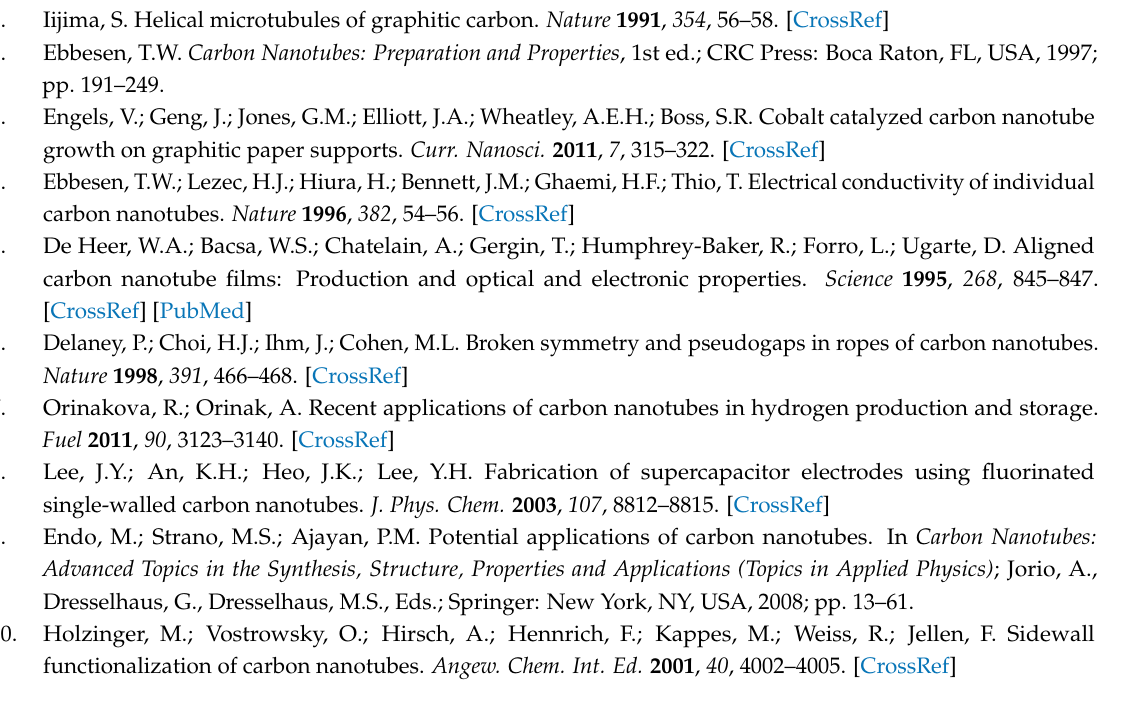
Table S1: Experimental conditions of MW-CNTs functionalization with branched and linear PFPE peroxides, Table S2: Experimental conditions of MW-CNTs fluorination with F 2 , Table S3: Weight evaluations for determination of linked, non-linked and decomposed portions of PFPEs in MW-CNTs functionalization with PFPE peroxides, Preparation of Comparative Examples—Physisorption of linear and branched PFPE Fluids on MW-CNTs, Table S4: Surface composition (at %) by XPS analysis referred to the comparative example, Table S5: Contact angle with water and BET surface area measurements referred to the comparative example, Table S6: Electrical resistivity at different pressures of MW-CNTs before and after PFPE-functionalization with branched and linear PFPE peroxides and after fluorination with F 2 , Figure S1: Normalized pore volumes (a) and pore areas (b) of the samples before (MW-CNTs) and after PFPE-functionalization with branched and linear peroxides ( I-BP50 and II-LP50 ), Figure S2: SEM micrographs of fluorinated MW-CNTs ( III-F ): 2.5 (a) and 100 kx